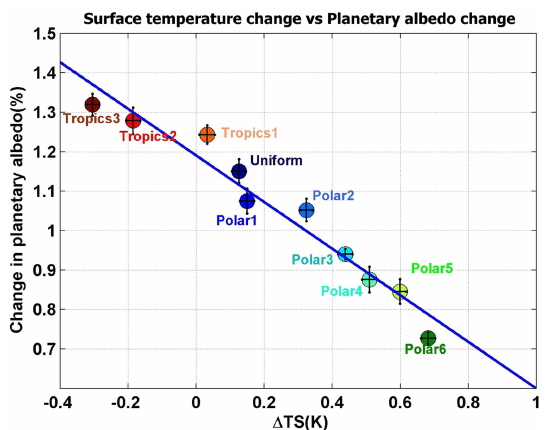
Figure 2. Change in planetary albedo in fixed-SST vs surface tem- perature change in slab ocean geoengineering simulations. The ra- diative forcing associated with albedo changes drive the tempera- ture changes. Polar cases have lower albedo changes relative to the Uniform case and hence are warmer and wetter while opposite is true for Tropics cases. The horizontal and vertical bars represent the standard error of the respective variables; temperature standard errors are calculated from the last 30 years of 60-year SOM sim- ulations while albedo standard errors are calculated from the last 20 years of 30-year fixed-SST